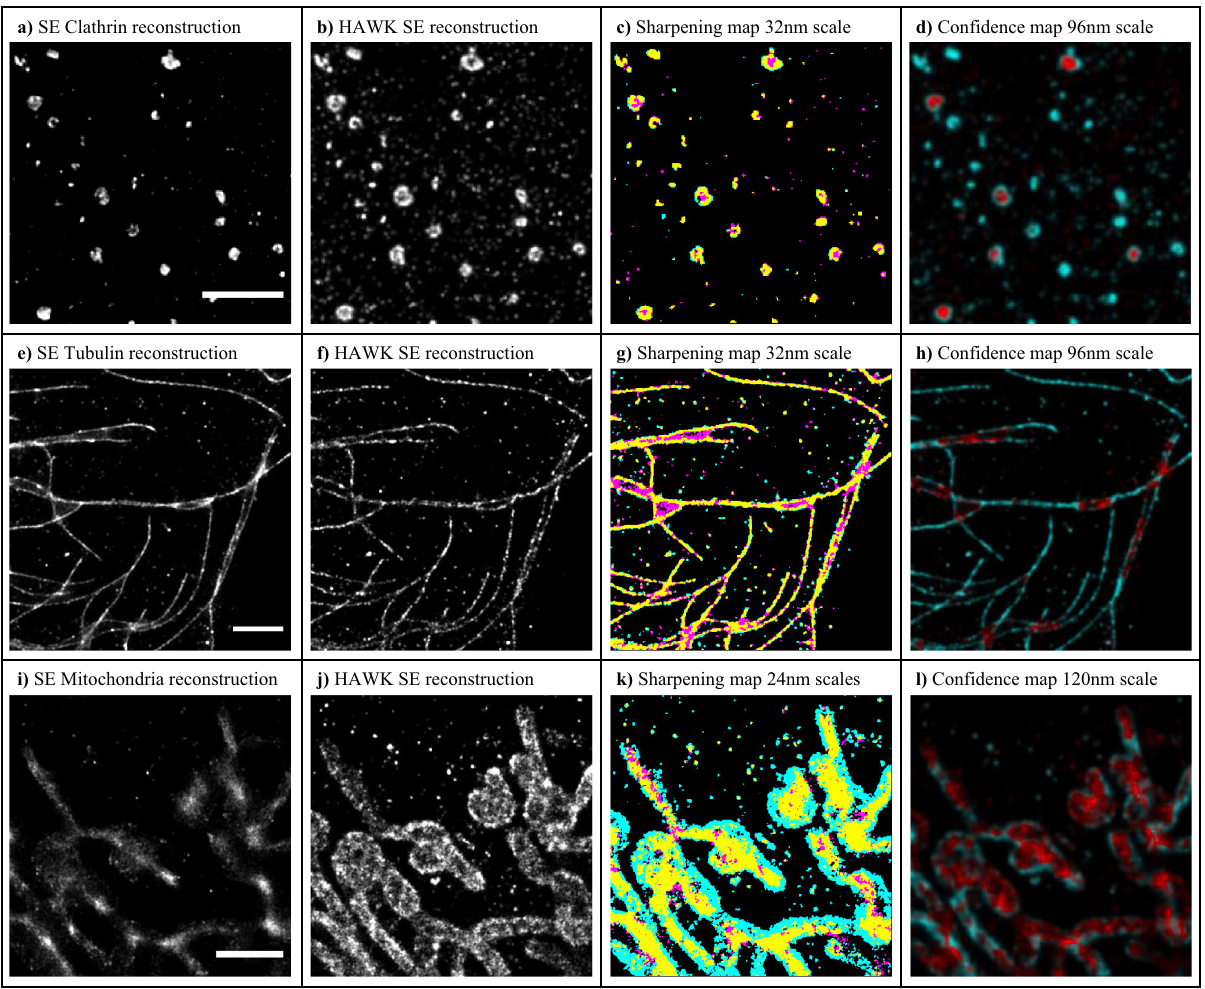
Fig. 5 HAWKMAN can assess reconstructions from a variety of different structures. Here, clathrin ( a – d ), tubulin ( e – h ) and the mitochondria epitope TOMM20 ( i – l ) have been imaged at medium-to-high density and evaluated with HAWKMAN. The test images were reconstructed using SE ThunderSTORM ( a , e , i ), and analysed with a reference image similarly reconstructed from the HAWK preprocessed dataset ( b , f , j ), and analysed using the sharpening map ( c , g , k ) and the con fi dence map ( d , h , l ). Data were displayed at a length scale of 32 nm ( c , g ) and 24 nm ( k ) for the sharpening maps, and at 96 nm ( g , h ) and 120 nm ( l ) for the con fi dence maps. The sharpening map threshold coef fi cients were 0.9 ( c ) and 0.7 ( g , k ). The con fi dence maps ( d , h , l ) highlight the substantial degrees of sharpening, particularly the TOMM20 reconstructions ( i – l ). Colouring as in Fig. 1, scale bars 2 μ Fig. 3) and reliable test, available as an ImageJ 18 plugin, which users can apply to verify the quality of their data.